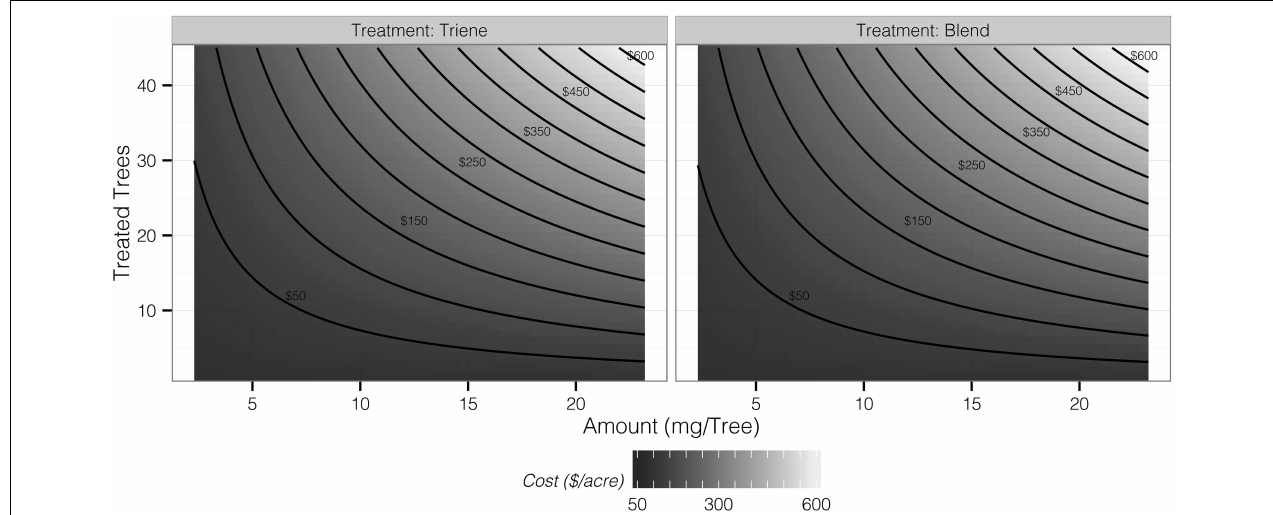
FIGURE 7 | Contours of application cost per acre as determined by the number of treated trees and amount of triene component applied.